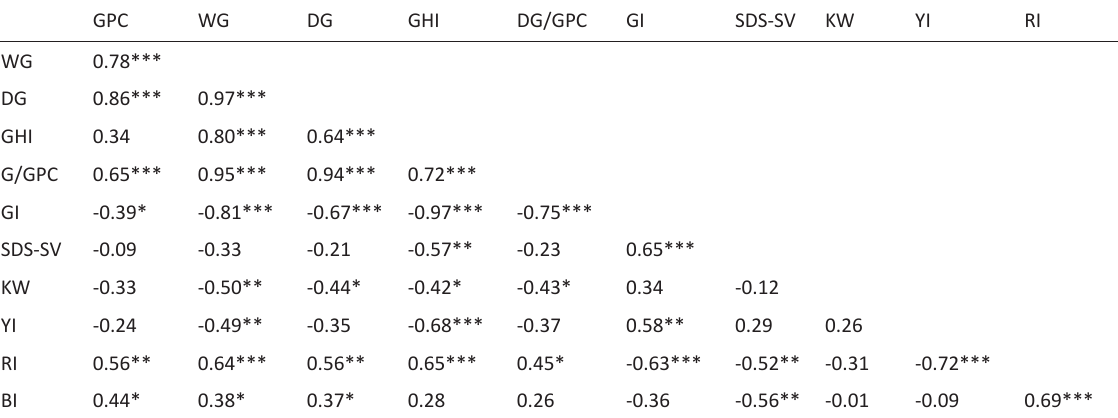
Table 6. Pearson correlation coefficients (R) among protein content (GPC), wet gluten (WG), dry gluten (DG), gluten hydration index (GHI), dry gluten/protein ratio (DG/GPC), gluten index (GI), sodium dodecyl sulphate sedimentation volume (SDS-SV), thousand- kernel weight (KW), and color indices (YI = yellow index; RI = red index; BI = brown index) of parental lines of wheat mapping populations grown in Valenzano (Bari, Italy) in 2013 GPC WG DG GHI DG/GPC GI